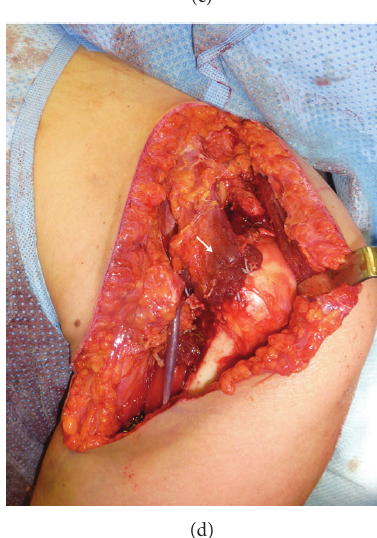
Figure 3: Surgical pictures of pectoralis minor pedicle flap transfer onto the anterior defect of glenohumeral joint capsule. (a) Mobile pedicle flap. (b) Insertion of the pedicle flap onto the anterior labrum and glenoid, covering the sizable defect of the anterior capsule. (c) Fixation of pedicle flap of pectoralis minor onto the lesser tuberosity, showing no tension on the pedicle. (d) Covered glenohumeral joint with pectoralis minor and overlying transferred split pectoralis major muscle to the medial part of greater tuberosity